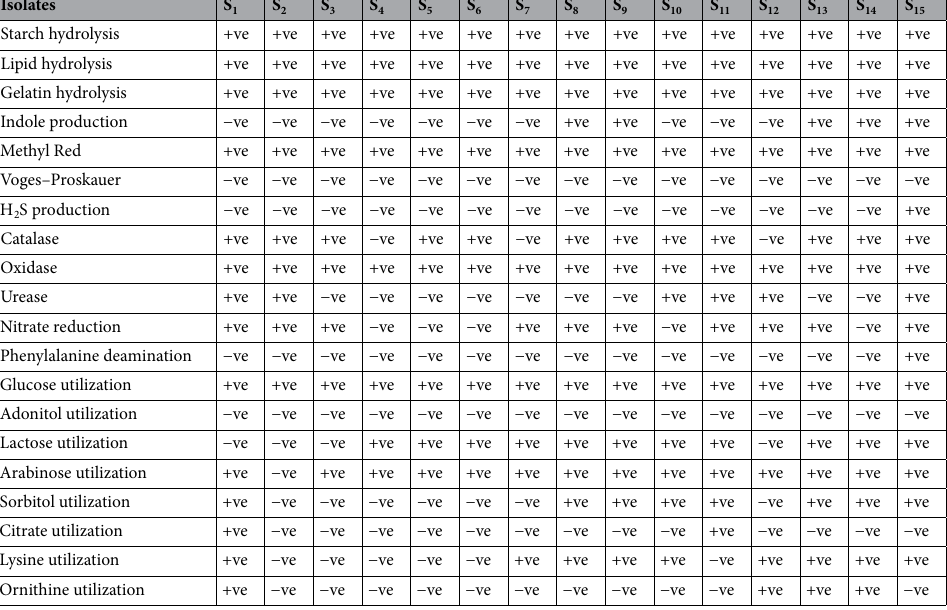
Table 4. Biochemical tests of